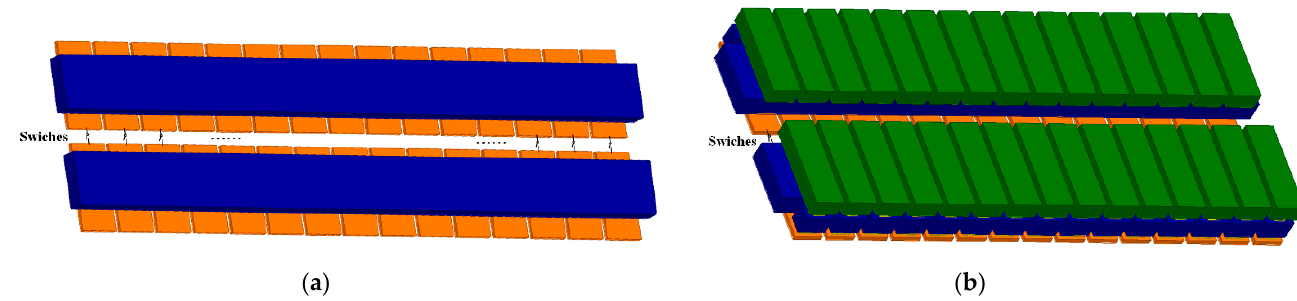
Figure 12. Diagrams of ( a ) the traditional DiCAD structure, and ( b ) the proposed DiCAD structure.